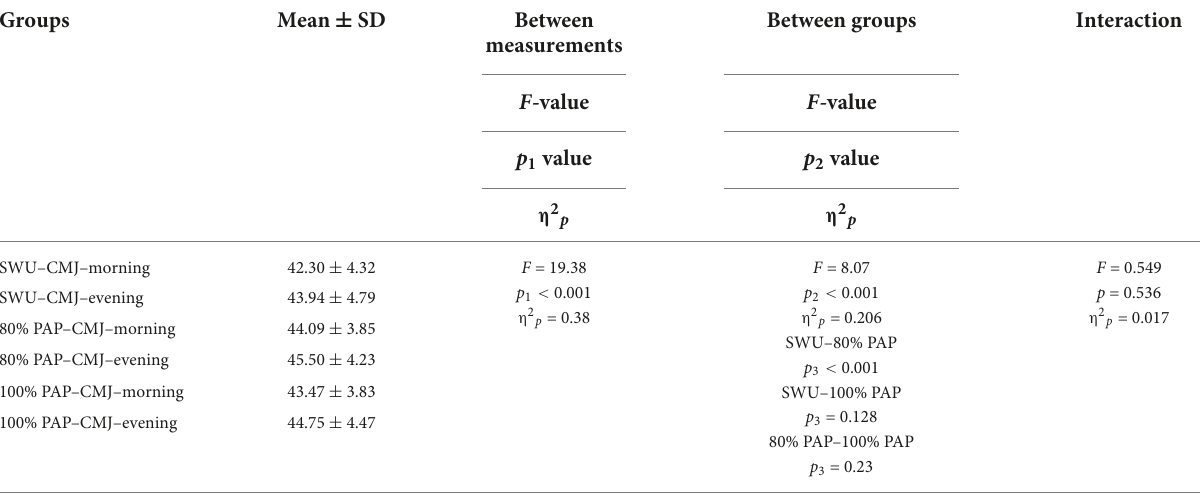
TABLE 4 Comparison of the measured values of